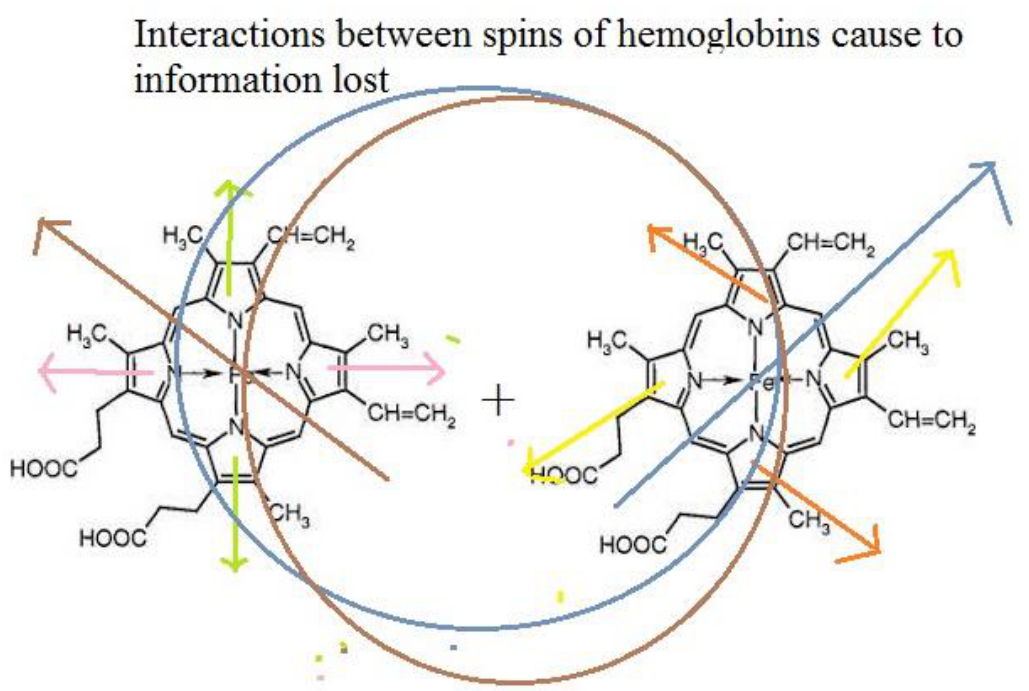
Figure 9. A new hemoglobin may induce new information into previous hemoglobin—a hypothesis.